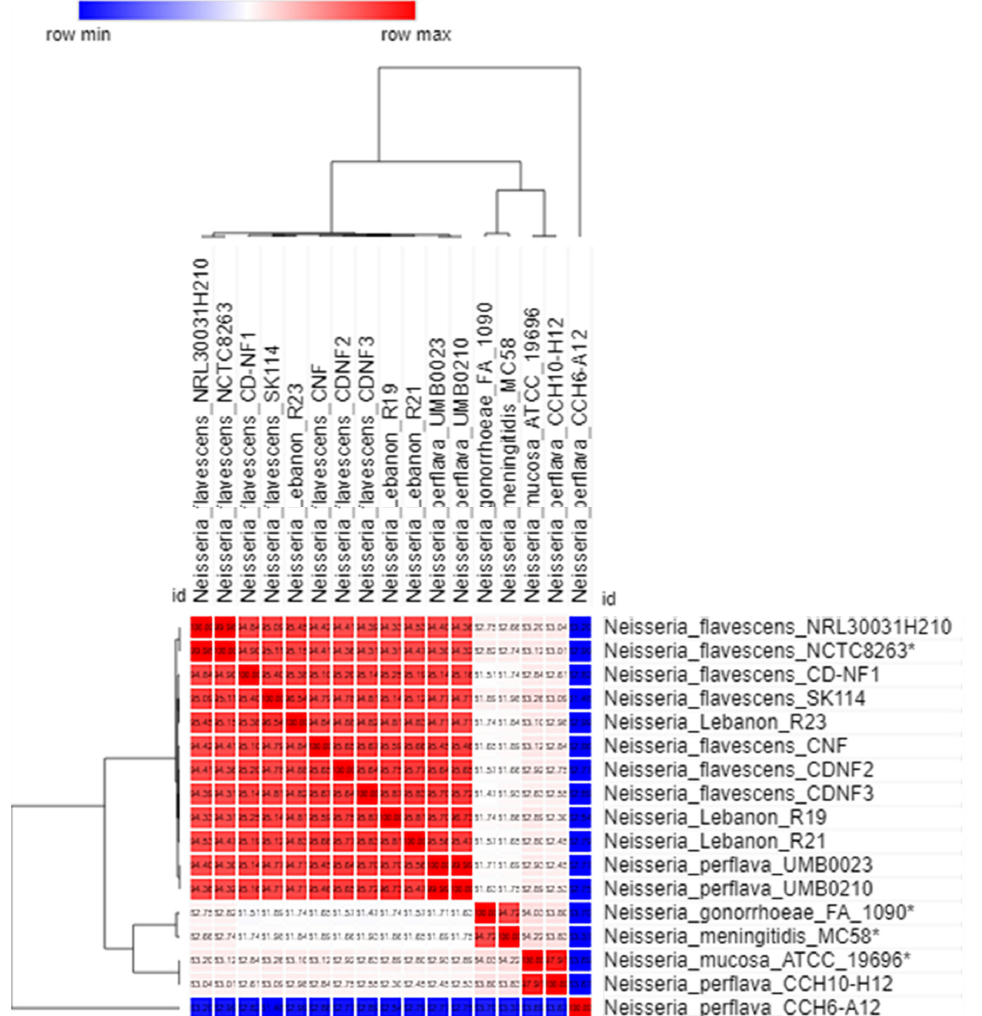
Figure 1. Functional heatmap of Neisseria flavescens and Neisseria perflava OrthoANI values. Reference genomes are marked by asterisk. Generation of the heatmap was done using Morpheus software (https://software.broadinstitute.org/morpheus/ (accessed on 2 November 2022)).